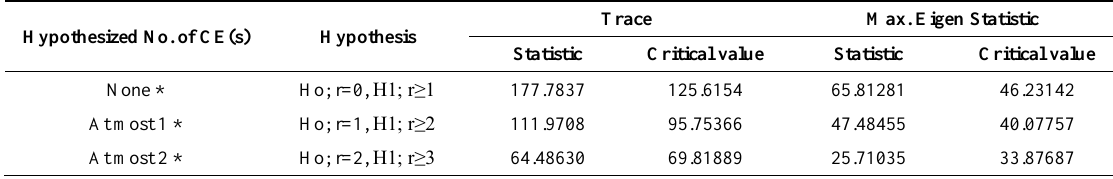
Table 2. Johnson Unrestricted Co-integration Rank Test